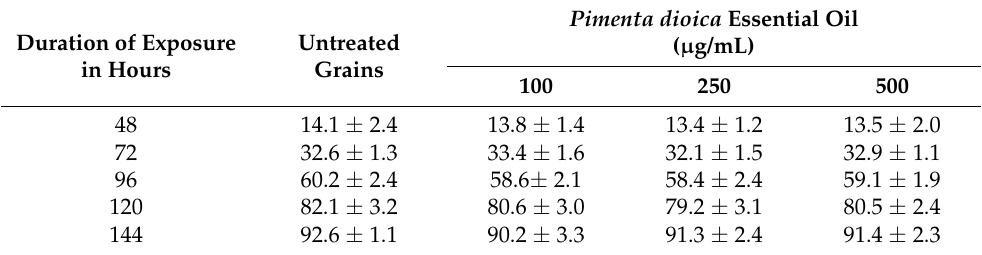
Table 3. Phytotoxic effect of Allspice ( Pimenta dioica) essential oil in terms of the germination potential of wheat (% germination).